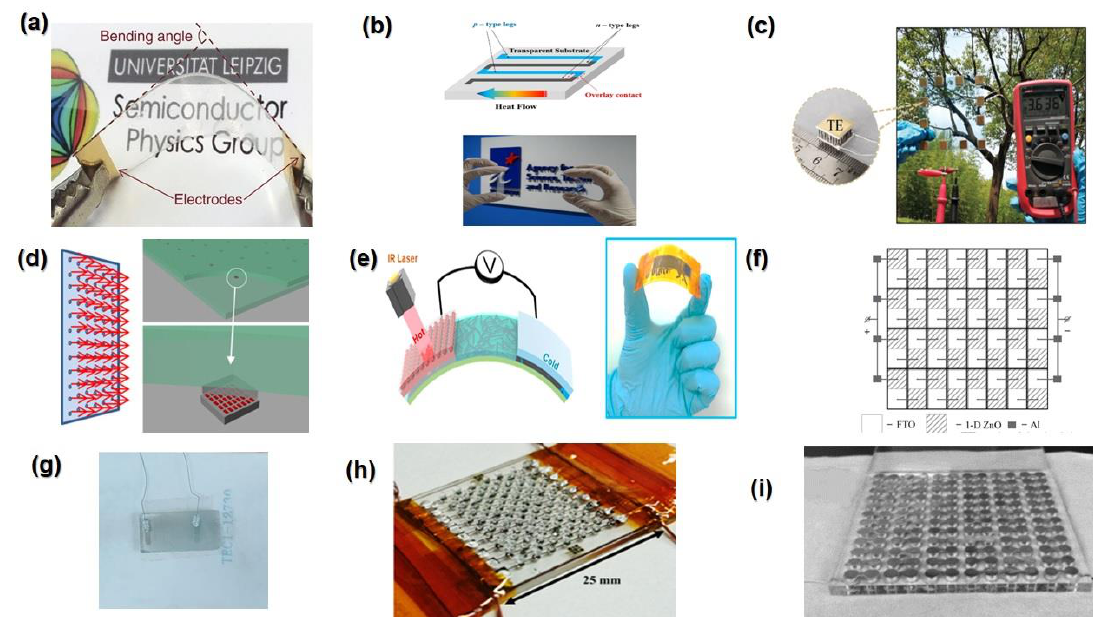
Figure 6. ( a ) Transparent flexible TE thin film made from CuI, adapted with permission from [112]. ( b ) Schematic representation of a basic configuration of p-type and n-type TE legs deposited on a substrate with a photo of the transparent TE device, adapted with permission from [113]. ( c ) Solar thermal electric power glass with 12 serially-connected Bi 2 Te 3 TE modules, adapted with permission from [114]. ( d ) Active thermal insulator (ATI) glazing system, adapted with permission from [116]. ( e ) Schematic illustration of PTENG illuminated by an IR laser and an image of flexible PTENG, adapted with permission from [117]. ( f , g ) Photograph of a ZnO/FTO TENG with Al contact and schematic illustration of the proposed design for a network of semi-transparent ZnO/FTO solar TE NGs with Al contact adapted with permission from [12]. ( h ) TEG with ball lenses, adapted with permission from [119]. ( i ) TE glazing consisting of 144 holes integrated with 72 pairs, adapted with permission from [23].